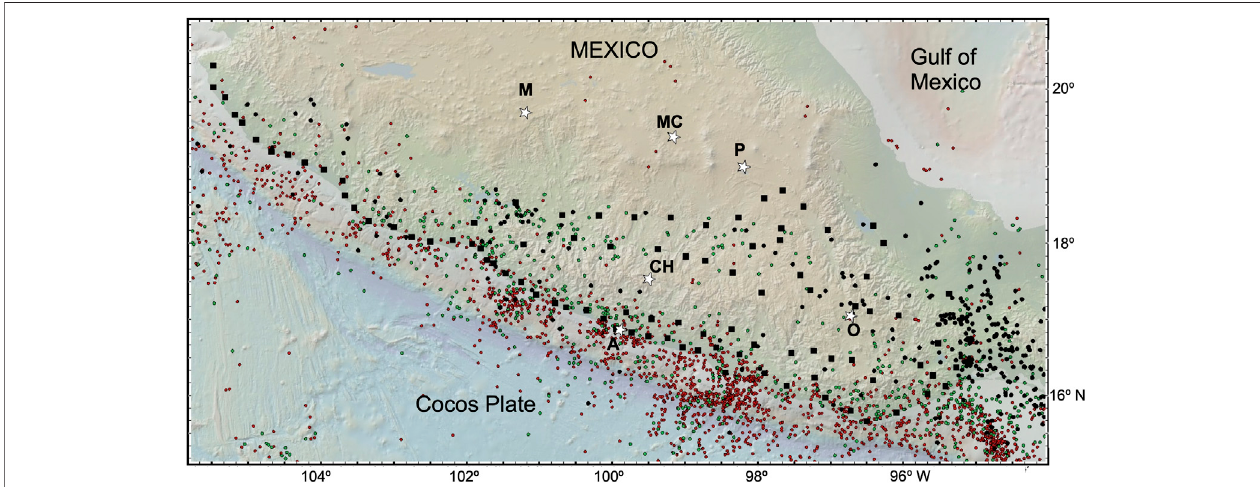
FIGURE1| Locationofaccelerographs oftheEEWSinMexico(black squares).WhitestarsarethecitiessubscribedtoSAMEXthatbroadcastalerts:A,Acapulco; Ch, Chilpancingo;M, Morelia;MC, Mexico City;O,Oaxaca; and P,Puebla. Earthquakes fromthecatalogoftheSeismologicalService ofMexicofrom 1January1970to 31 December 2021: focal depths from 0 to 30 km (red dots), 30 – 70 km (green dots) and deeper than 70 km (black